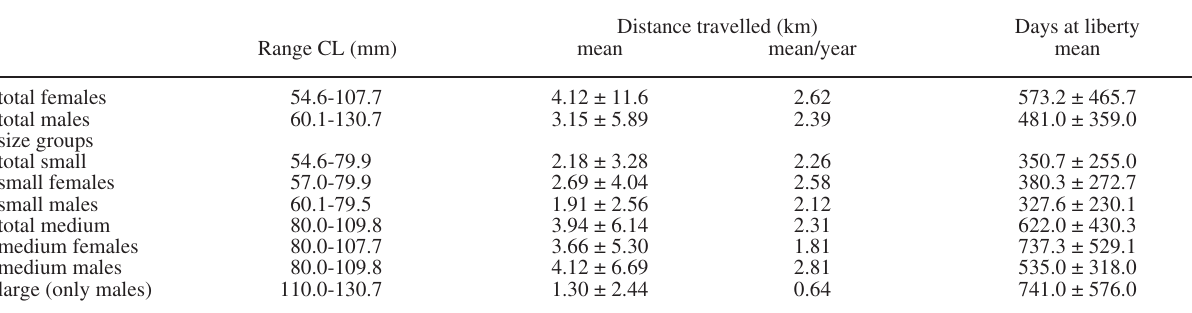
Table 2. – range of carapace length (mm), mean distance travelled (km) and mean of days at liberty of tagged and recaptured lobsters for different sex and size groups.